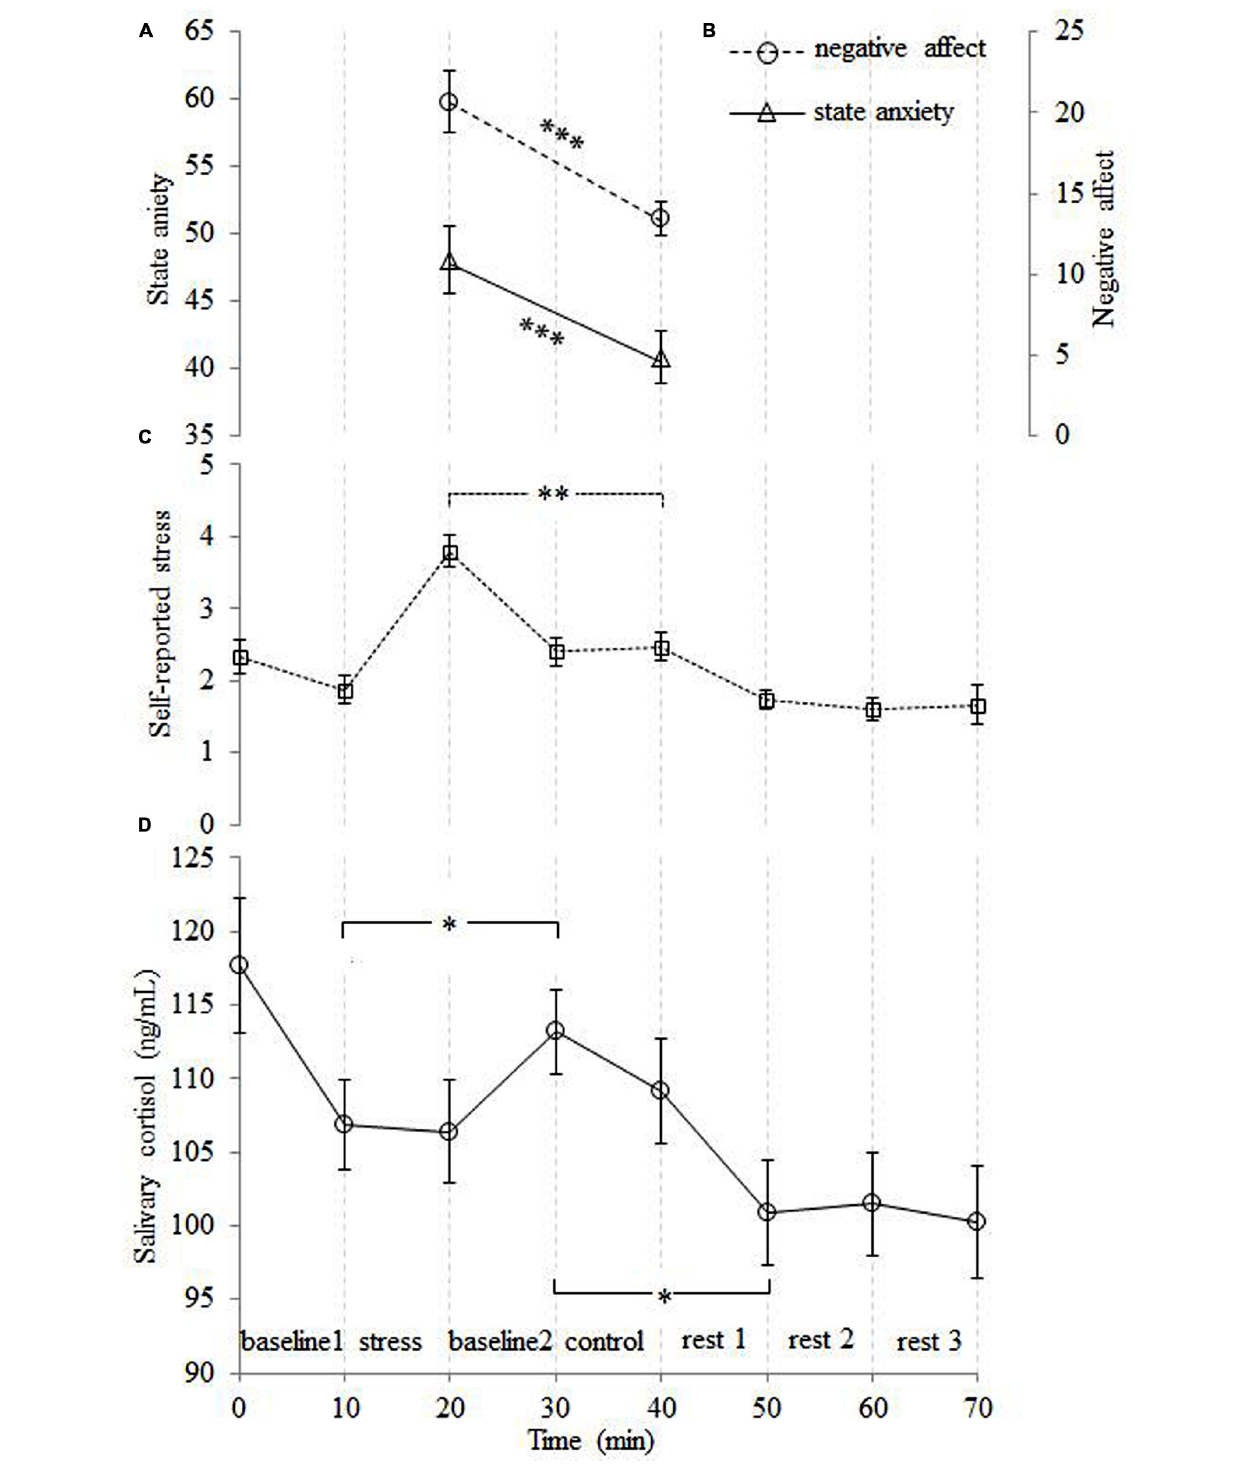
FIGURE 2 | The time courses of the averaged subjective ratings of state anxiety (A), negative affect (B), self-reported stress (C) and salivary cortisol levels (D). The level of subjective stress was higher for the stress than control condition. The level of cortisol was obviously increased after the stress condition, and then decreased sharply after the control condition. Note that the peak in the salivary cortisol level lags behind the other measures. Error bars represent the standard error of the mean. ∗ p < 0.05, ∗∗ p < 0.01, ∗∗∗ p < 0.001.